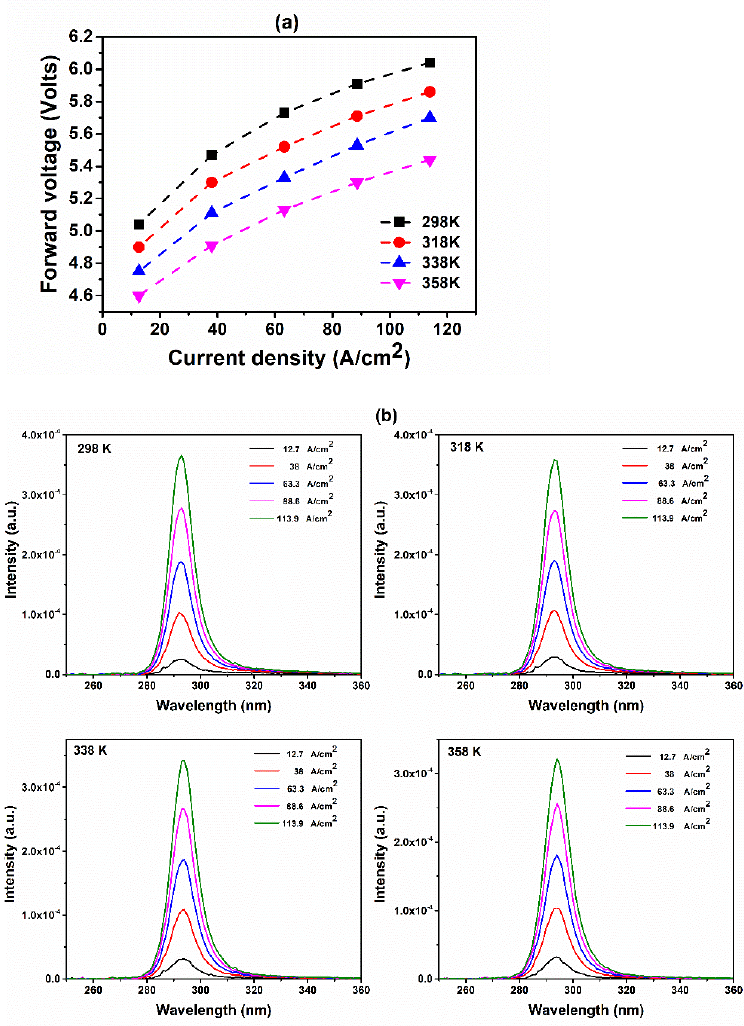
Figure 3. ( a ) Forward voltages and ( b ) EL spectral data of the 293 nm UVB-LED recorded at various forward currents and temperatures of 298, 318, 338, and 358 forward currents and temperatures of 298, 318, 338, and 358 K.